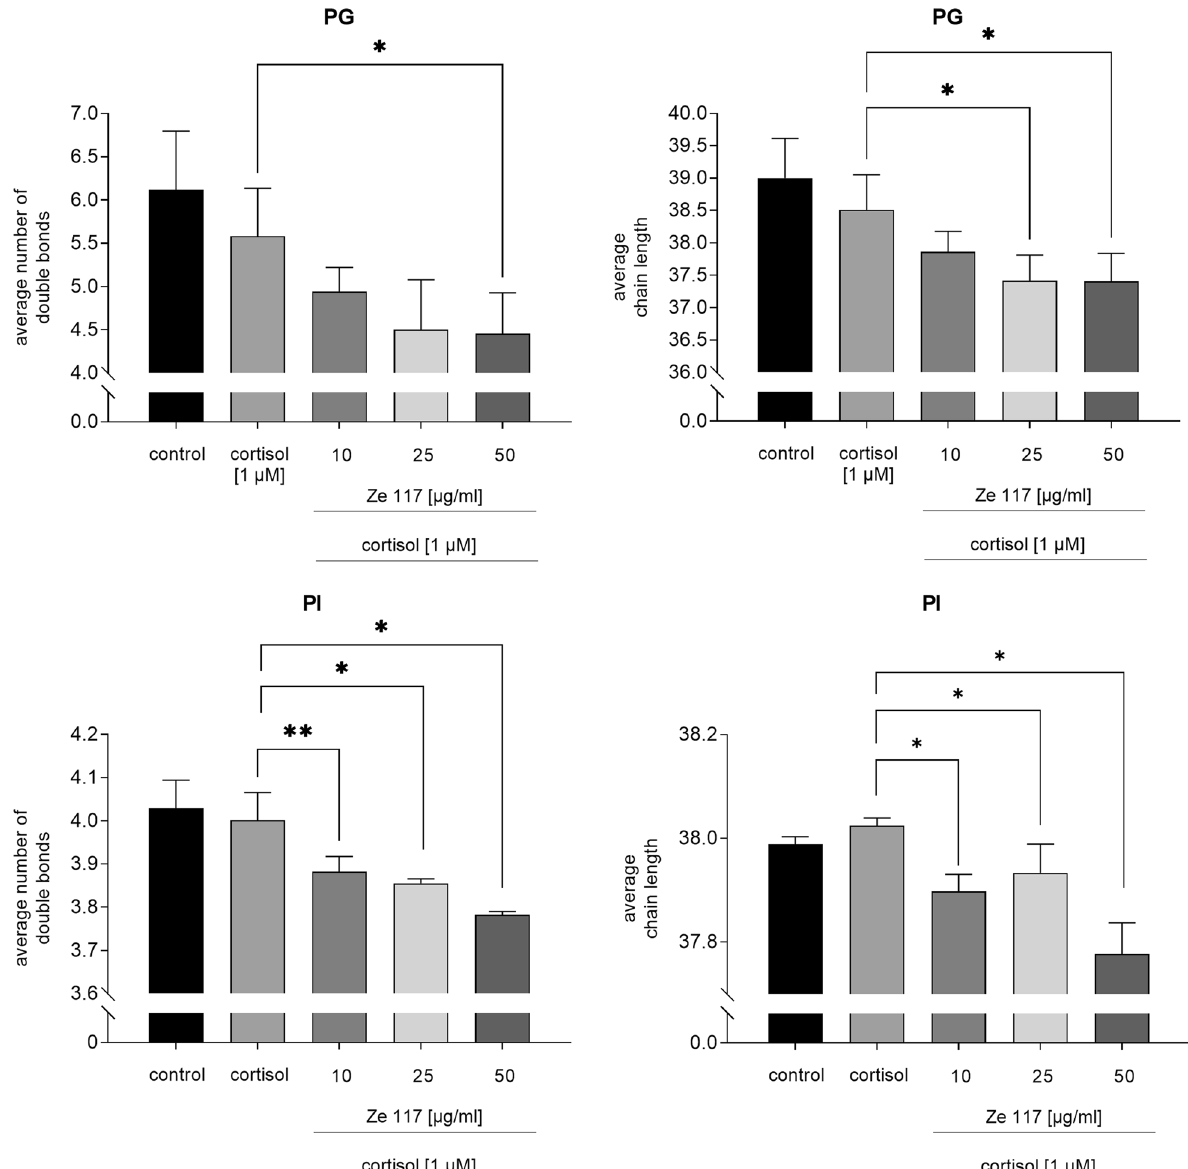
Fig. 6 Average chain length and average number of double bonds of the lipid classes of phosphatidylglycerols (PG) and phoshpatidylinositols (PI) after cortisol and cortisol/Ze 117 preincubation, respectively. For statistical evaluation the cortisol condition was compared to the control. Average chain length and average number of double bonds of cortisol/Ze 117 pre-treated cells were compared with the cortisol condition. *Marked values are significantly different from corresponding control with p < 0.05 (**p < 0.01, ***p < 0.001, ****p < 0.0001) determined by one-way ANOVA (n followed by Holm-Šídák